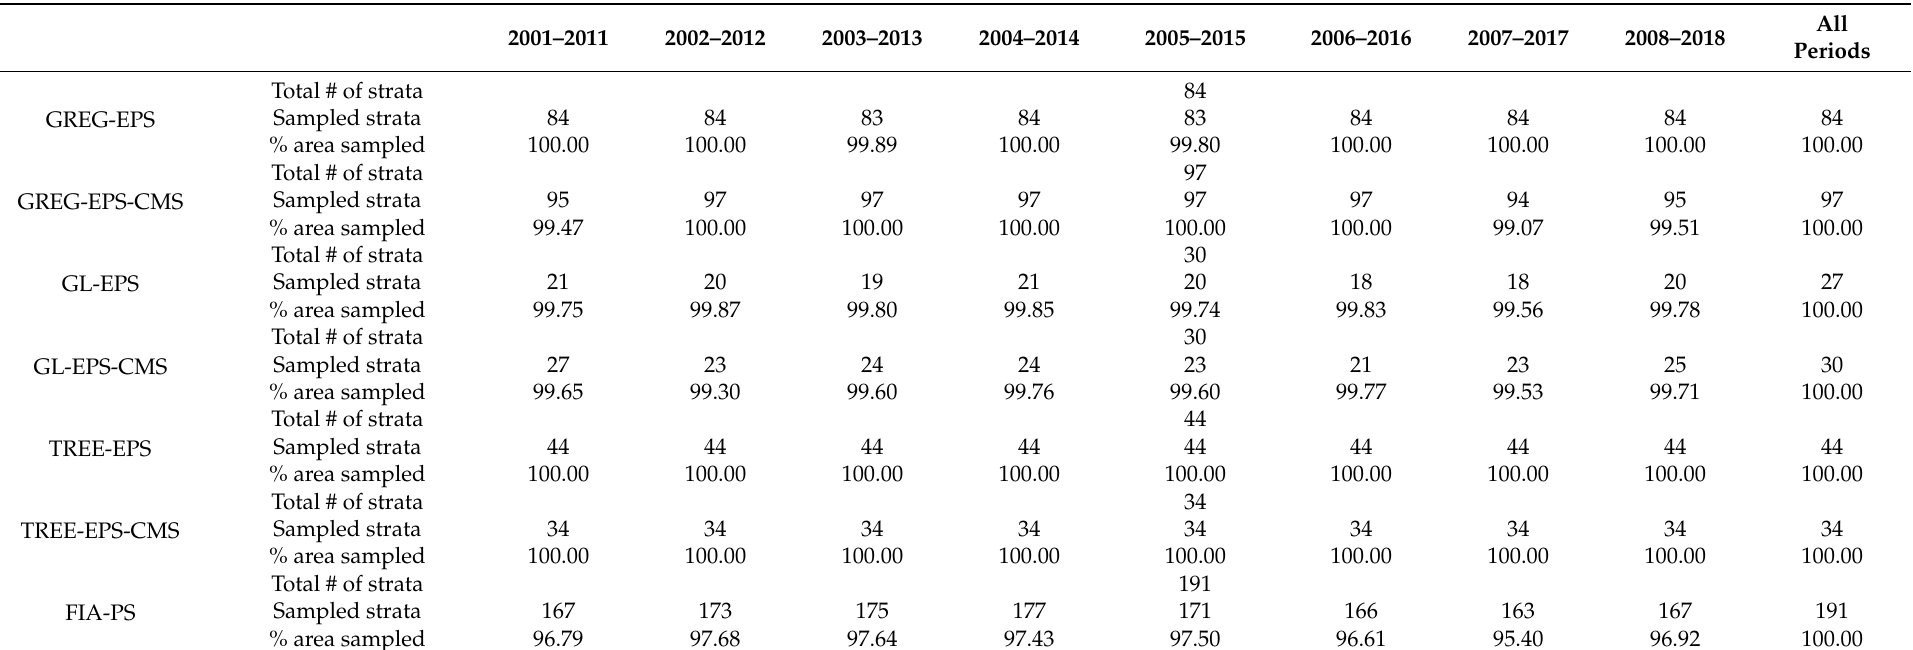
Table 3. Total number of strata, number of sampled strata, and proportion of area sampled by 10-year periods and for all 10-year periods